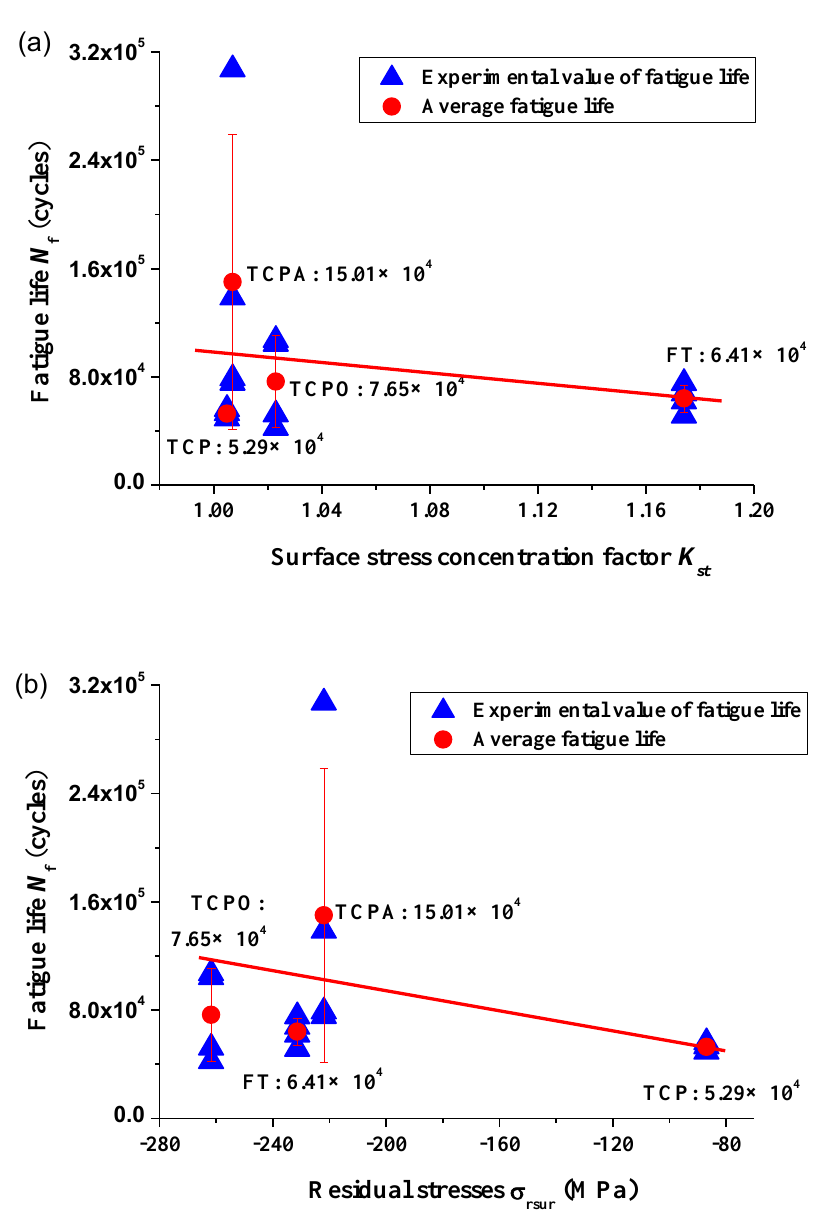
Figure 9. The effects of K st and σ rsur on fatigue life: ( a ) effect of K st on fatigue life and ( b ) effect of σ rsur on fatigue life. on fatigue